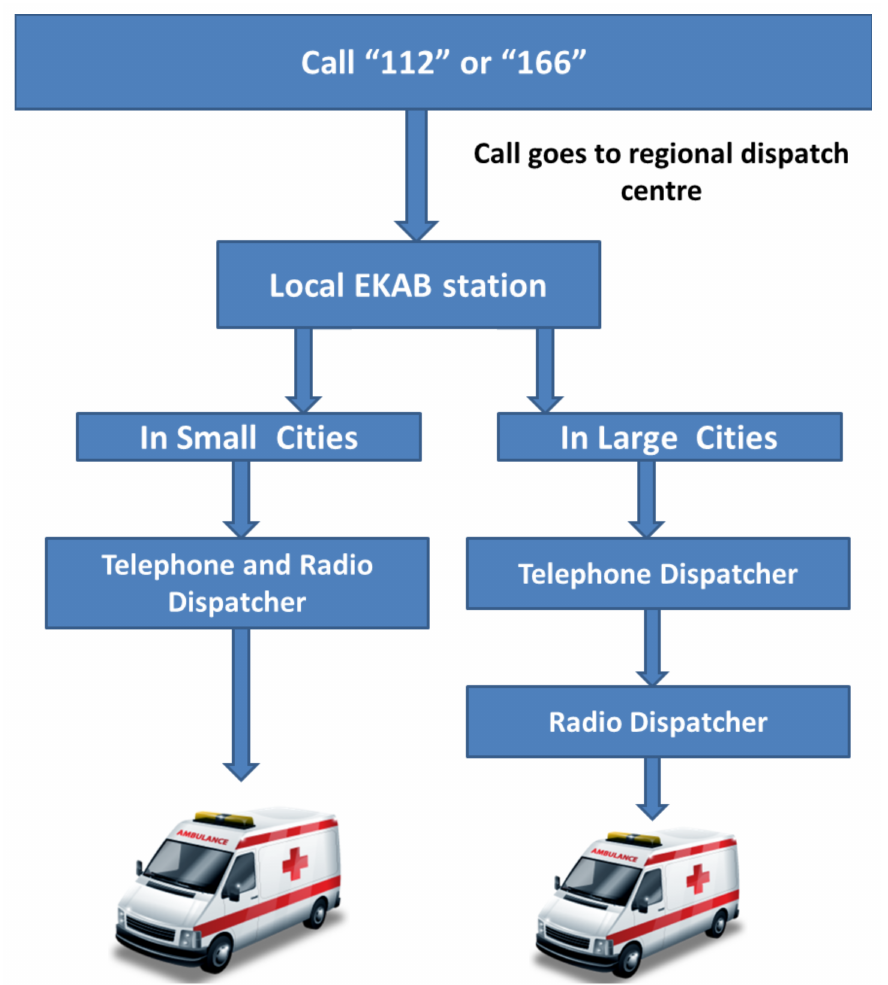
Figure 3. Dispatch process flowchart for Greece. All EKAB stations have their dispatch centres. EKAB is accessible throughout the country firstly by the European emergency phone number “112” as well as by the toll-free, easy to remember “166”. The call goes to the regional dispatch centre. A telephone dispatcher receives various calls and prioritises them according to importance or urgency. In large cities, telephone dispatchers mobilize the appropriate number of nearest available mobile ambulances or Mobile Intensive Care Units (MICUs) via radio communications and provide directions to arrive at the scene of the incident. On the contrary, in small cities, the dispatcher telephones the nearest ambulance station or else passes mobilization instructions to the radio operator if an ambulance is already mobile. Adapted from: Page C et al.